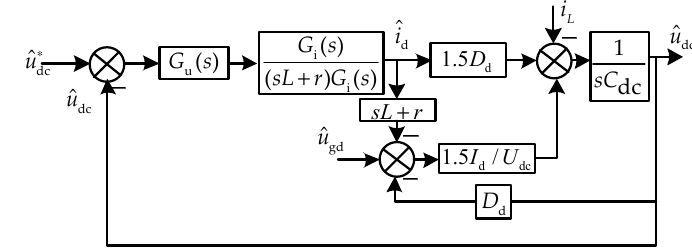
Figure 6. PWM rectifier d-axis small signal model.